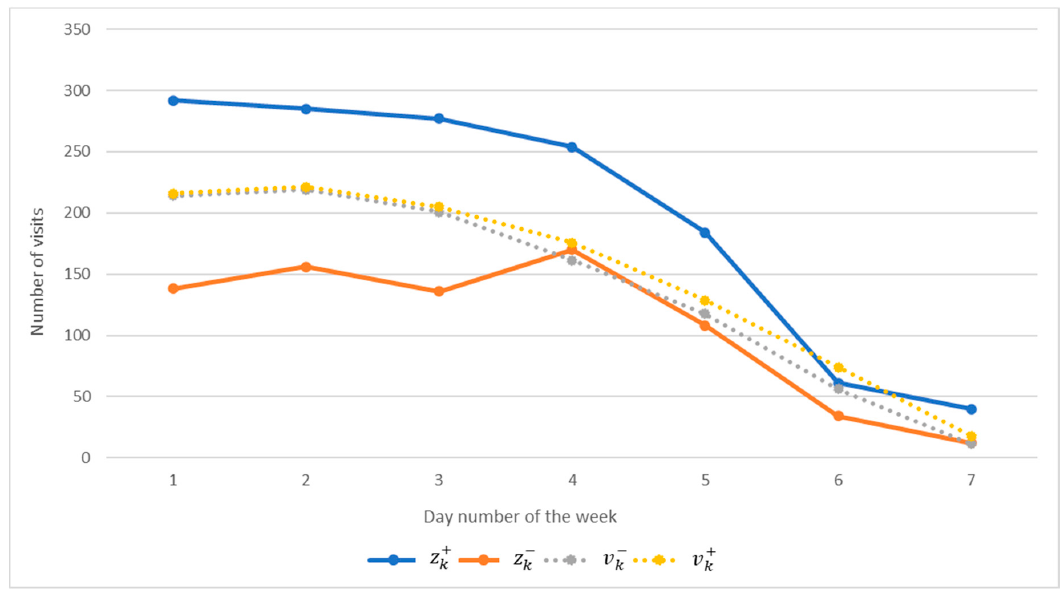
Figure 4. Predicted values of user activity on the specified resource, obtained using IDM (17).